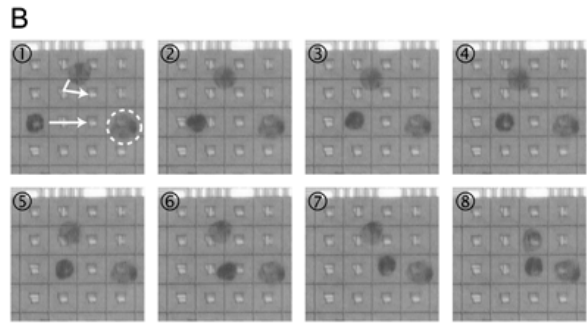
Figure 5. Manipulation of bovine capillary endothelial (BCE) cells. ( A ) A single BCE cell trapped on the center of a microcoil (current generating the magnetic field: 20 mA of amplitude, with 50% of duty cycle). The cell is then moved over the array to make a round trip; ( B ) Manipulation of three cells. The cell inside the dotted circle is trapped and kept on the corresponding microcoil, while the two remaining cells are moved toward it. Reproduced with permission from Lee et al. [53]. Copyright © Royal Society of Chemistry, 2007.